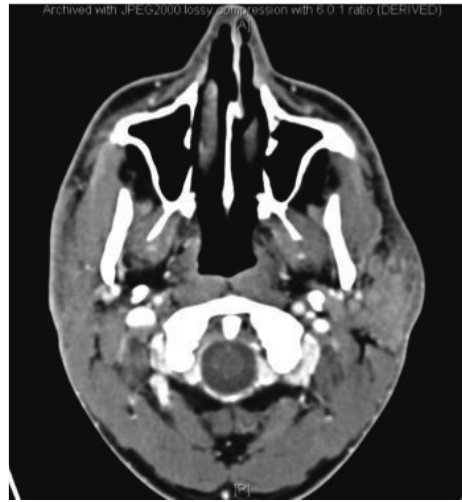
Figure 3: CT axial cut: left parotid gland enlargement with het- erogeneous density, multiple different sized intraglandular lymph nodes.